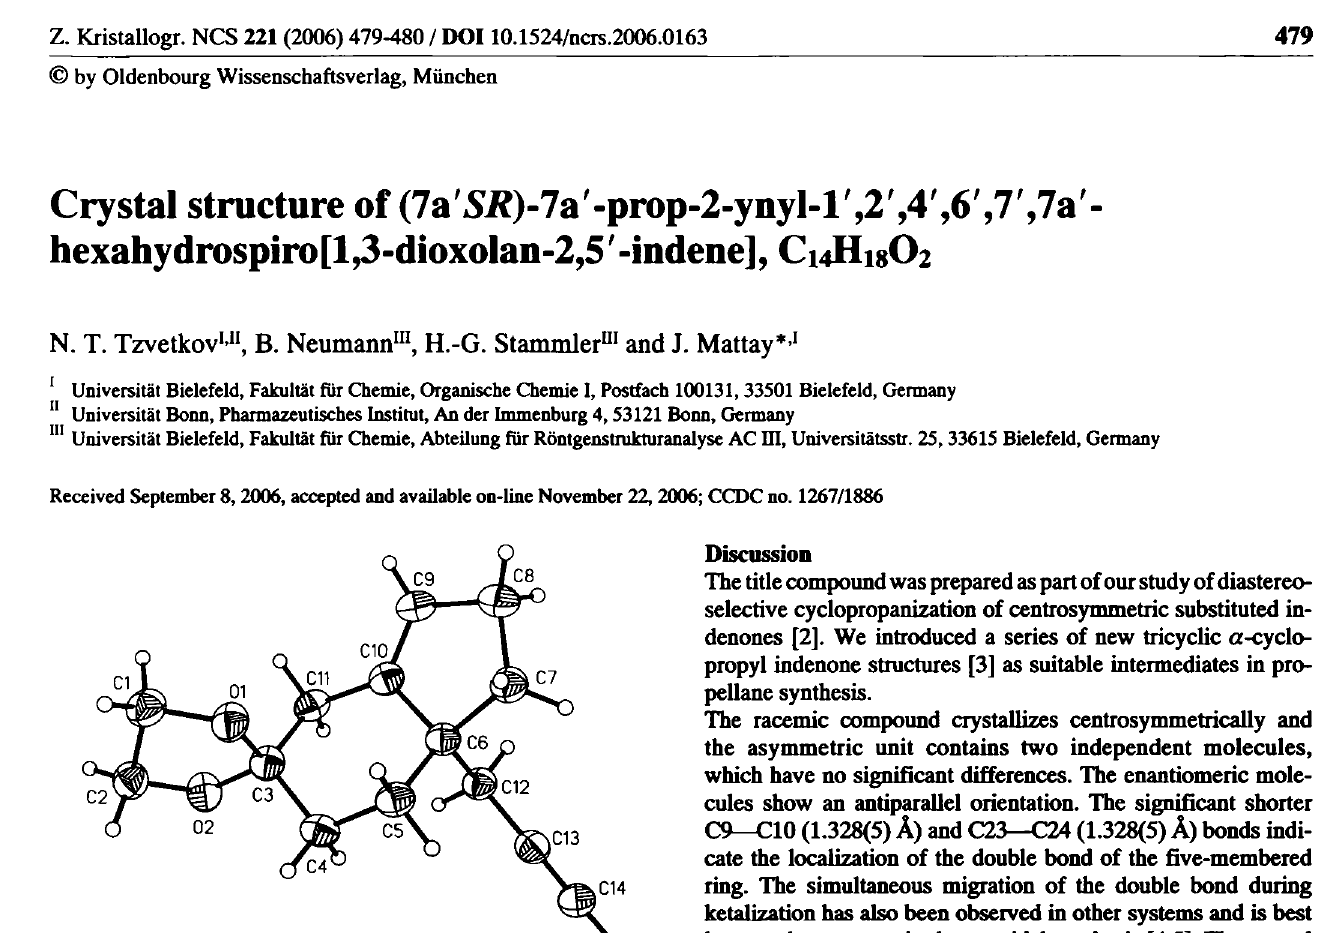
Table 1. Data collection and handling.